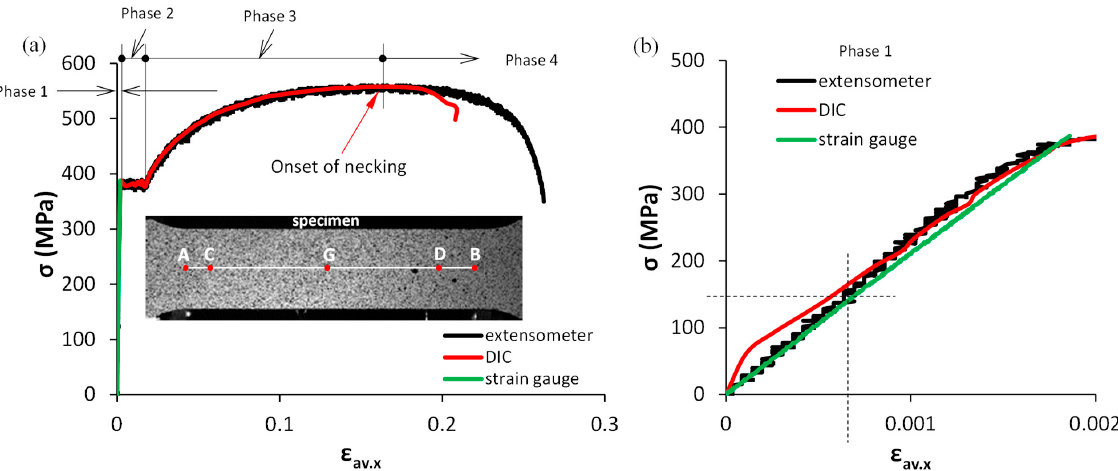
Figure 3. ( a ) The curve of the stress ( σ ) versus the longitudinal average strain ( ε av.x ), and ( b ) the enlargement of ( a ) within Phase 1 (elastic region). The ε av.x was measured using an extensometer with a gauge length of 30 mm, DIC (over the AB line), and a strain gauge. A strain gauge and DIC were used to measure the average transversal strains. Their transversal stress–strain curves are shown in Figure 4. Apparently, the transversal strain below a stress level of 301 MPa (much higher than the 166 MPa for the longitudinal strain).